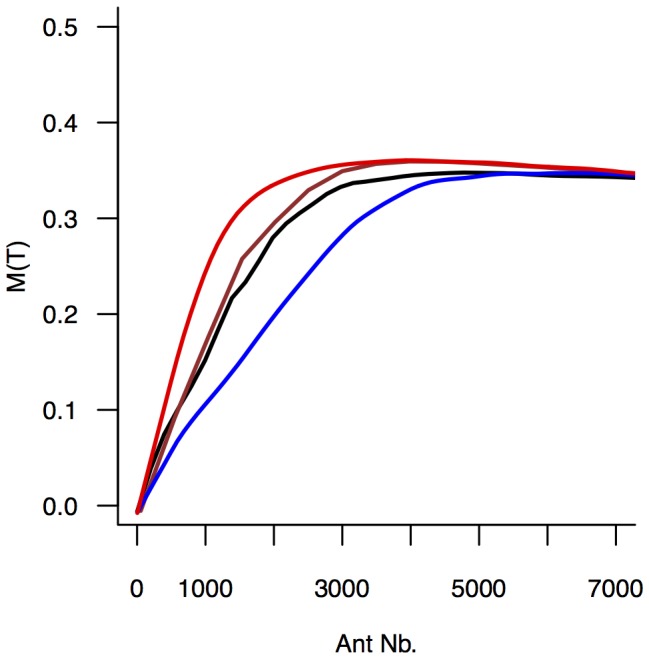
Meshedness  at the end of experiments as a function of the number of workers, predicted by the simplified model in a space with no boundary, either using the set of median values of parameters (brown line), picking randomly a parameter set among the experimental ones (black line), or using the set of median values but with the highest lateral nodes formation rate value (red line) or the lowest one (blue line).The number of workers was repeatedly picked uniformly between A = 1 and A = 7,000 for each condition and the lines report the corresponding tendency obtained by a lowess procedure (see Fig. S5). The meshedness increases as the number of workers increases, from tree-like structures () towards triangular networks () up to a saturation value. The predictions including the experimental variance of parameter estimations (black lines) show that the transition of  induced by the increase of  is robust to behavioural noise.